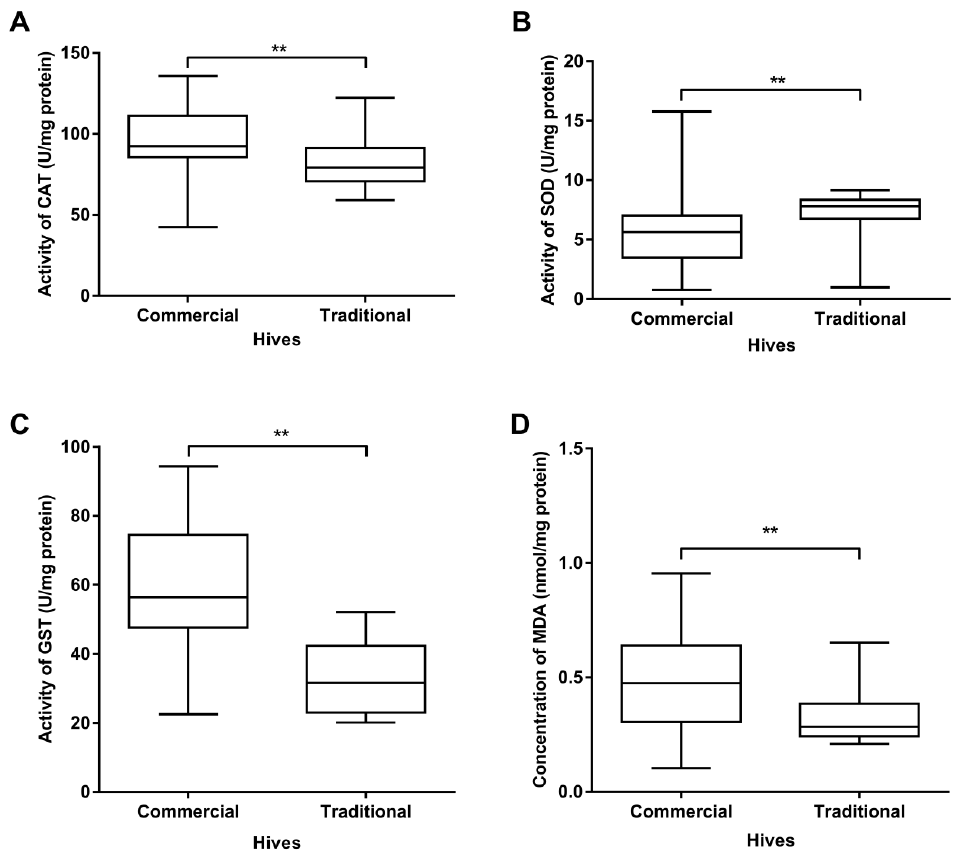
Figure 2. Activities of superoxide dismutase (SOD) ( A ), catalase (CAT) ( B ) and glutathione S-transferase (GST) ( C ) and malondialdehyde (MDA) concentrations ( D ) in adult bees kept in commercial and traditional hives. ** Significant at p < 0.01 level.